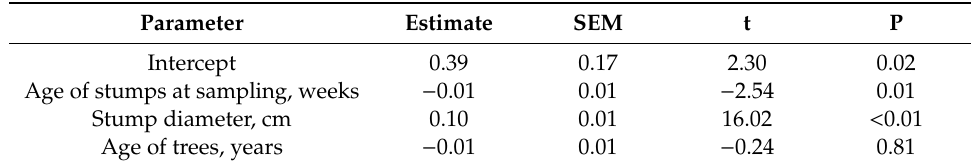
Table 4. Regression analysis summary for individual effects of parameters on area occupied by Heterobasidion . r2 = 0.63; SEM, standard error of the mean. Parameter Estimate SEM P Intercept